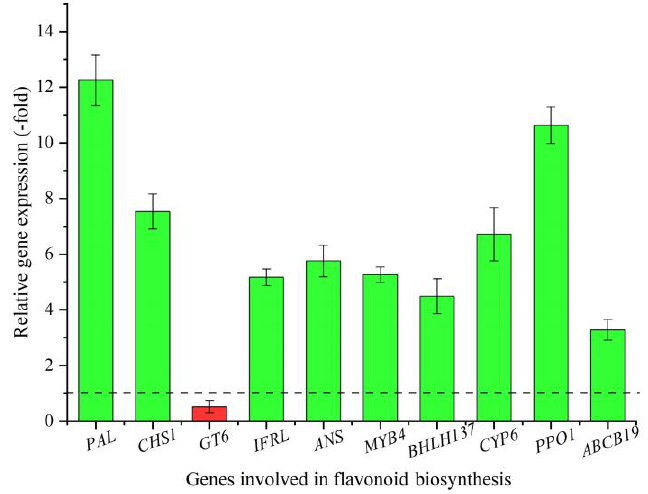
Figure 3. The REL of genes involved in flavonoid biosynthesis at 3300 vs. 2300 m, as determined by qRT-PCR (mean ± SD, n = 3). The dotted line in the image differentiates up-regulation (>1) and down-regulation (<1) at 3300 vs. 2300 m, respectively. The columns highlighted in green represent up-regulation and red represents down-regulation. The same below.